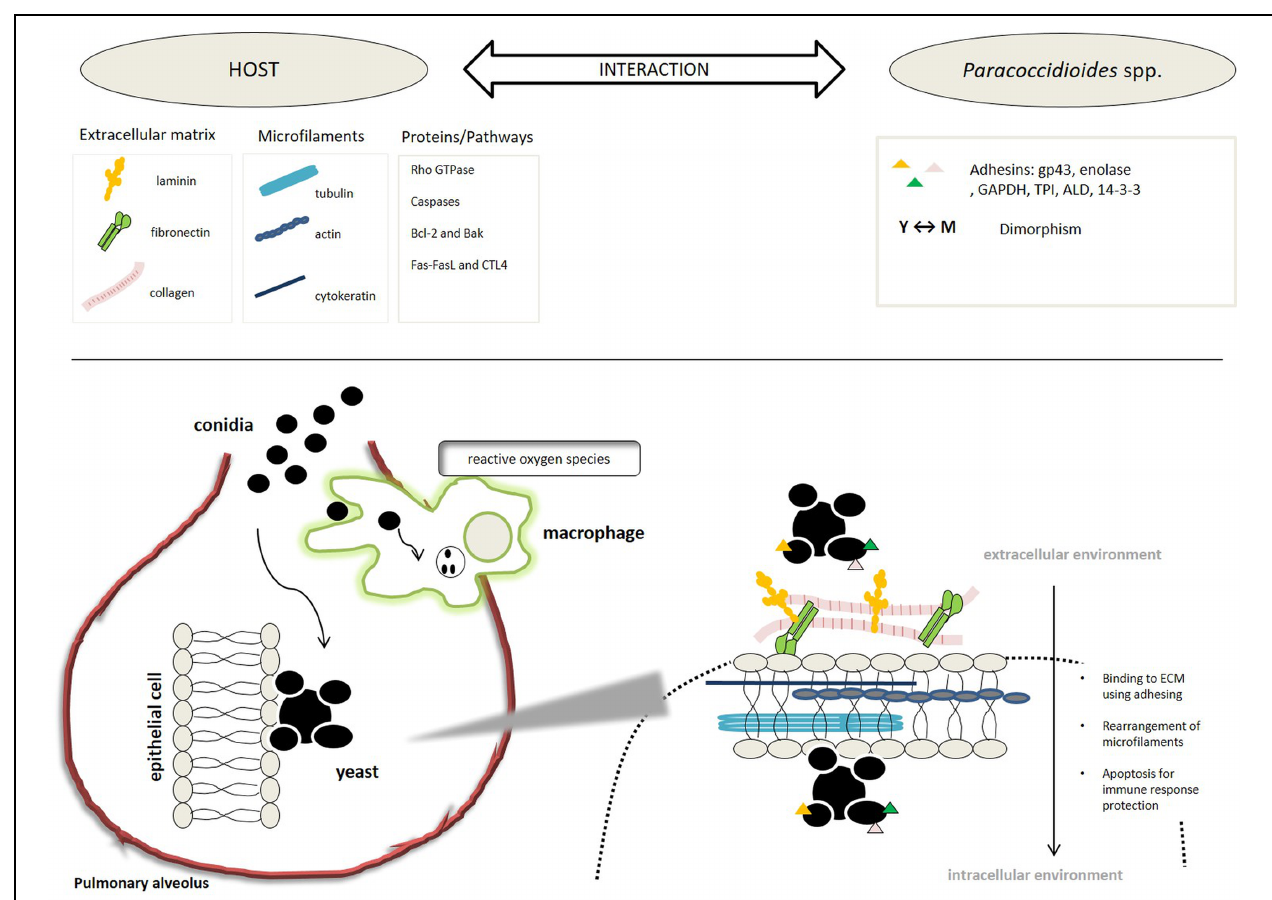
FIGURE 2 | Schematic representation of the steps, processes, and molecules involved in the Paracoccidioides -host interaction.